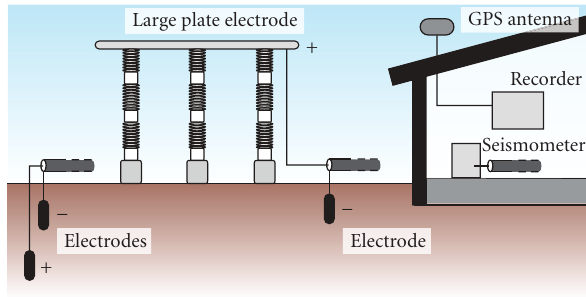
Figure 2: Schematic of the observation system. The pair of reference electrodes measured the vertical component of the earth potential di ff erence (EPD). The positive electrode was buried 2.5 m deep; the negative one was buried 0.5 m deep. The aluminum large plate electrode measured signals related to the vertical component of the atmospheric electricity (AE). The plate area was 4 × 4m 2 . It was supported by five insulators at a height of about 4m. The velocity sensor (only at Sennan), which was fixed on the concrete base of a barn near the sensors, measured the up-down component of the ground surface